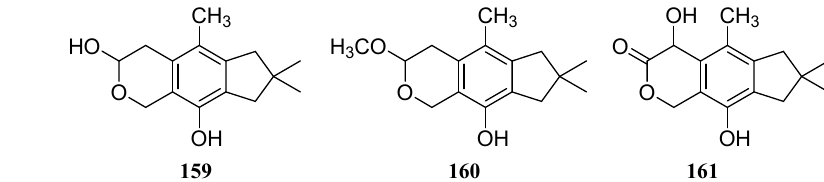
Figure 18. Structures of illudalane - type sesquiterpenoids 159 – 161 .